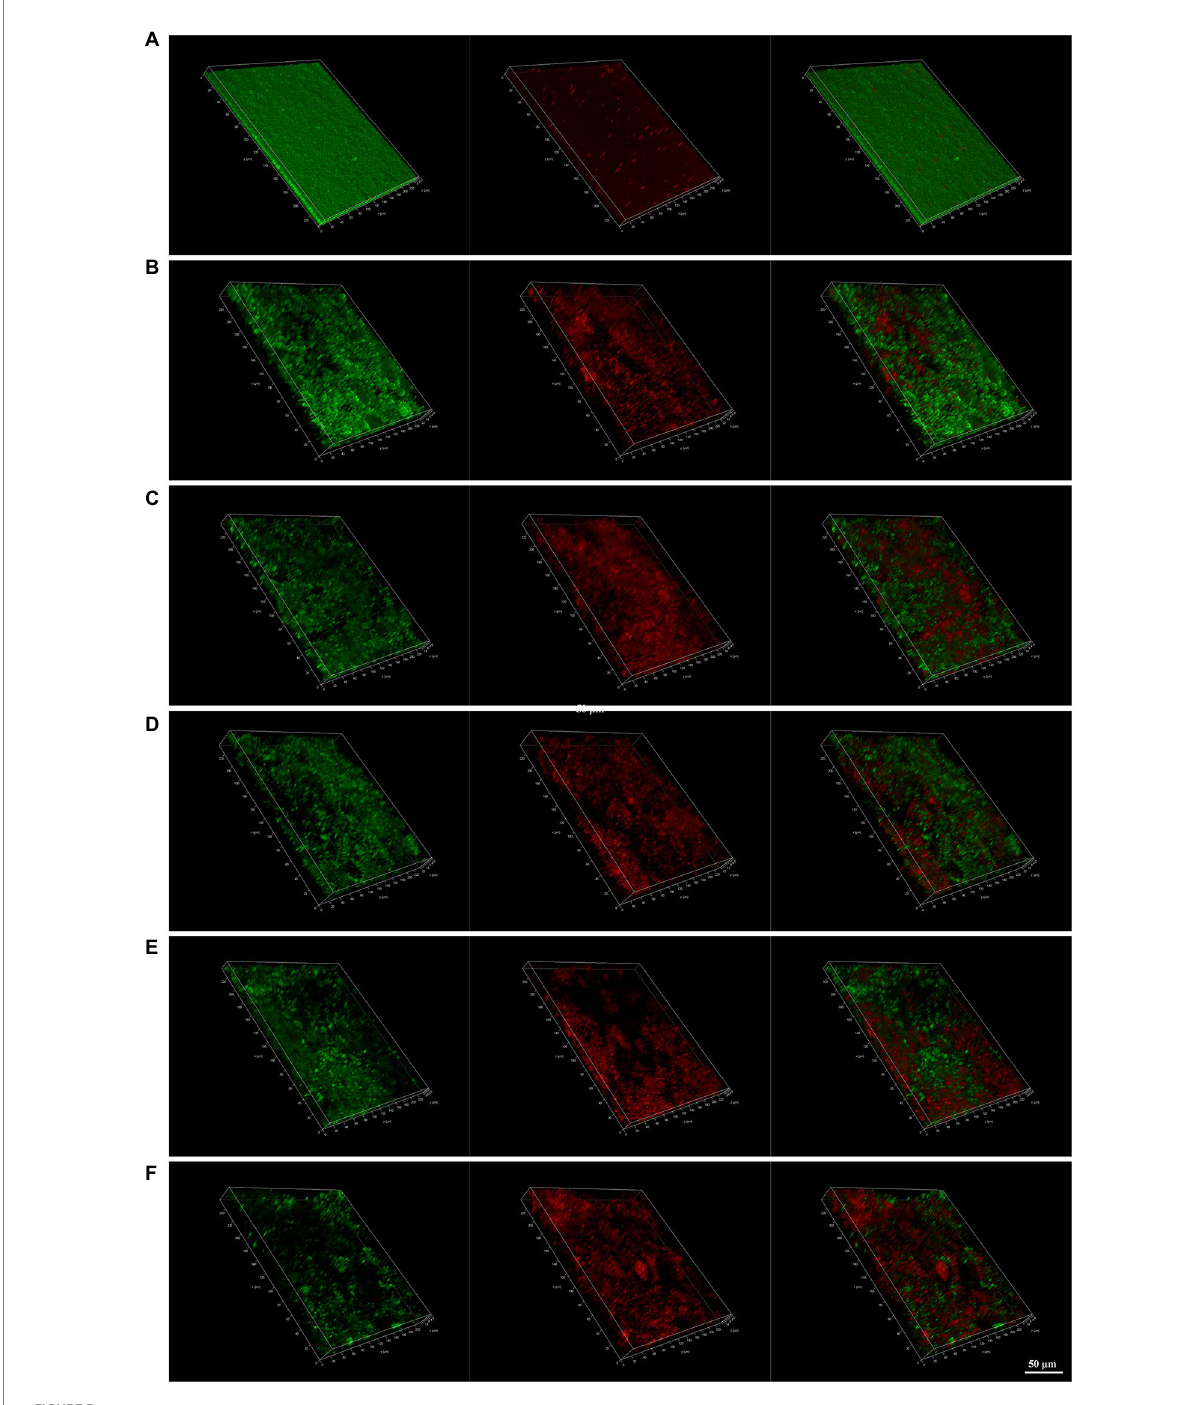
FIGURE 5 Confocal laser scanning microscope (CLSM) images of H. pylori 26,695–16R strain biofilms. Cells stained with membrane-permeant SYTO 9 (green) and membrane-impermeant propidium iodide (red) were visualized by CLSM. (A) Control group; (B) treated with Pa β N (20 μ g/ml); (C) treated with CCCP (1 μ g/ml); (D) treated with JWC 16 μ g/ml; (E) treated with JWC 32 μ g/ml; (F) treated with JWC 64 μ